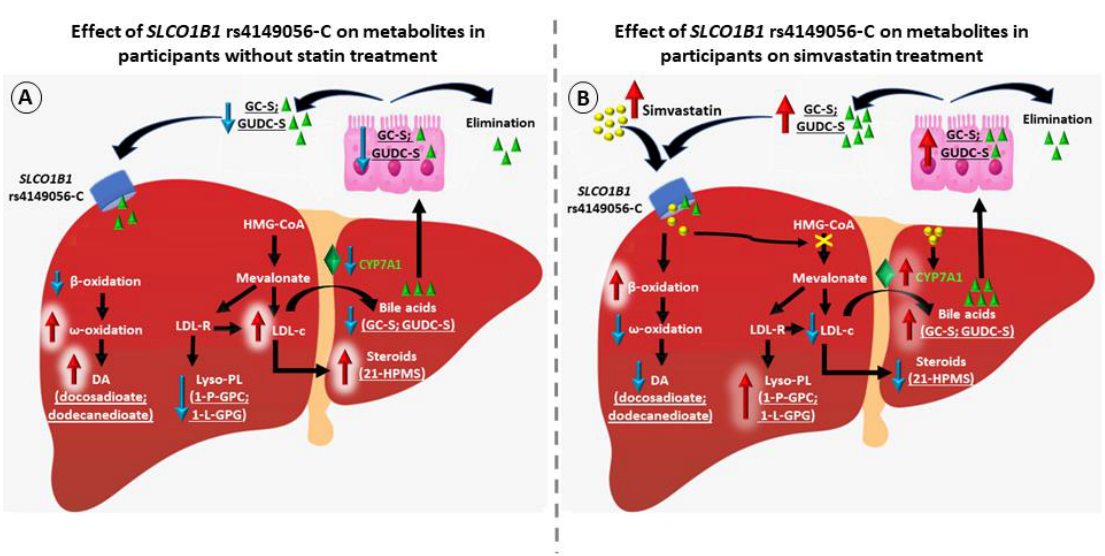
Figure 3. Comparison of the effects of SLCO1B1 rs4149056-C on metabolites in participants without statin treatment and with simvastatin treatment. ( A ). Omega oxidation pathway is increased in participants with SLCO1B1 rs4149056-C without statin treatment, increasing dicarboxylic acid levels. Mevalonate pathway is activated, increasing cholesterol levels in participants without statin treatment, and thus increasing steroids levels. LDL-R expression is increased, leading to decreased lyso-PL species. CYP7A1, which converts cholesterol to bile acids, is not activated, leading to decreased conversion of cholesterol to bile acids, contributing to increase in cholesterol levels and decrease in bile acids levels in plasma. ( B ). SLCO1B1 rs4149056-C has a declined activity of the OATP1B1 transporter, leading to a poor transport of simvastatin into hepatocytes, increasing simvastatin levels in plasma. Once in the liver, simvastatin increases β -oxidation of fatty acids, preventing ω -oxidation pathway, resulting in decreased levels of dicarboxylic acids. Due to the poor simvastatin transport into the liver, HMG-CoA reductase is not efficiently inhibited, leading to a lower expression of LDL-R, and consequently an increase of lyso-PL species. Simvastatin activates CYP7A1, which converts the excess cholesterol into bile acids, decreasing cholesterol levels and increasing bile acid levels. Cholesterol levels are decreased, and steroids, which are its downstream metabolites, are also decreased. Bile acids undergo sulfation in the liver and are transported to the intestine, where they can be excreted or reabsorbed. Simvastatin and sulfated bile acids compete for SLCO1B1 transporter, and its decreased activity leads to an increase in both compounds in plasma. Abbreviations: 1-L-GPG, 1-linoleoyl-GPG; 1-P-GPC, 1-palmitoleoyl-GPC; DA, dicarboxylic acid; GC-S, glycocholenate sulfate; GUDC-S, glycoursodeoxycholate sulfate; HMG-CoA, 3-hydroxy-3-m ethylglutaryl coenzyme A; HPMS, hydroxypregnenolone monosulfate; LDL, low-density lipoprotein, SLCO1B1, solute carrier organic anion transporter family member 1B1.